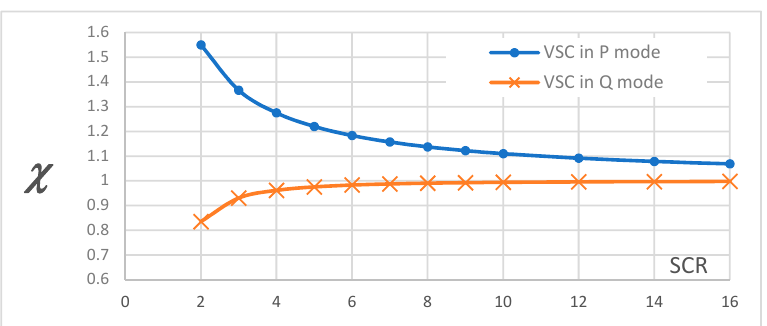
10 of 13 Figure 2. EPRI 9-bus test case with a VSC-HVDC connection at bus 8. For the VSC connected to bus 8 (REC), it was considered that current components (d, q) were both limited to 0.75 p.u. on the system’s MVA, while the total current was limited to 0.825 p.u. (10% over the VSC nominal current). Three-phase short circuits were considered: F1, close to bus 8 (where the VSC is con- nected); F2 at bus 6 (considered, relative to the VSC, a remote fault); and F3, at bus 3, closer to the VSC than bus 6. The first case is discussed analytically, while for the other, the rmsVSC methodology is applied and results are compared to those of PSS ® CAPE.